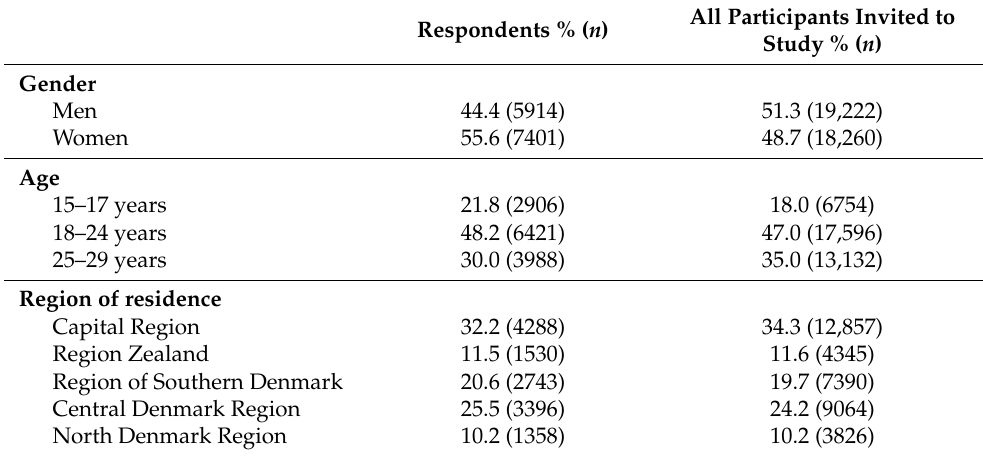
Table 1. Sociodemographic characteristics of the study population.